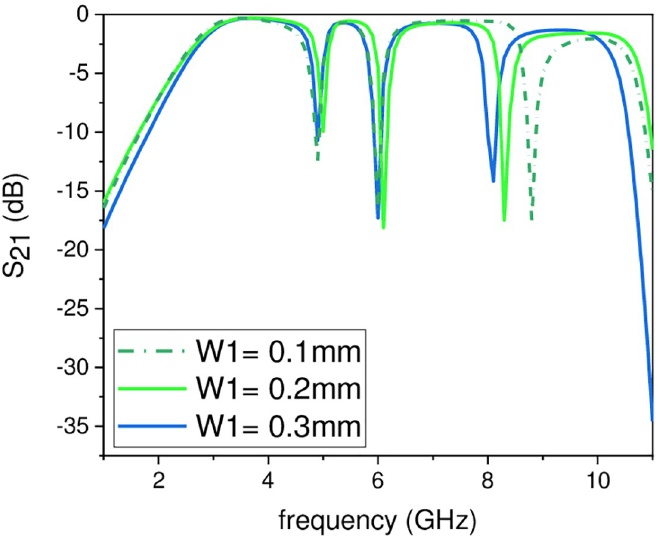
Fig 11. Experimental frequency plot of third NB control by varying W 1